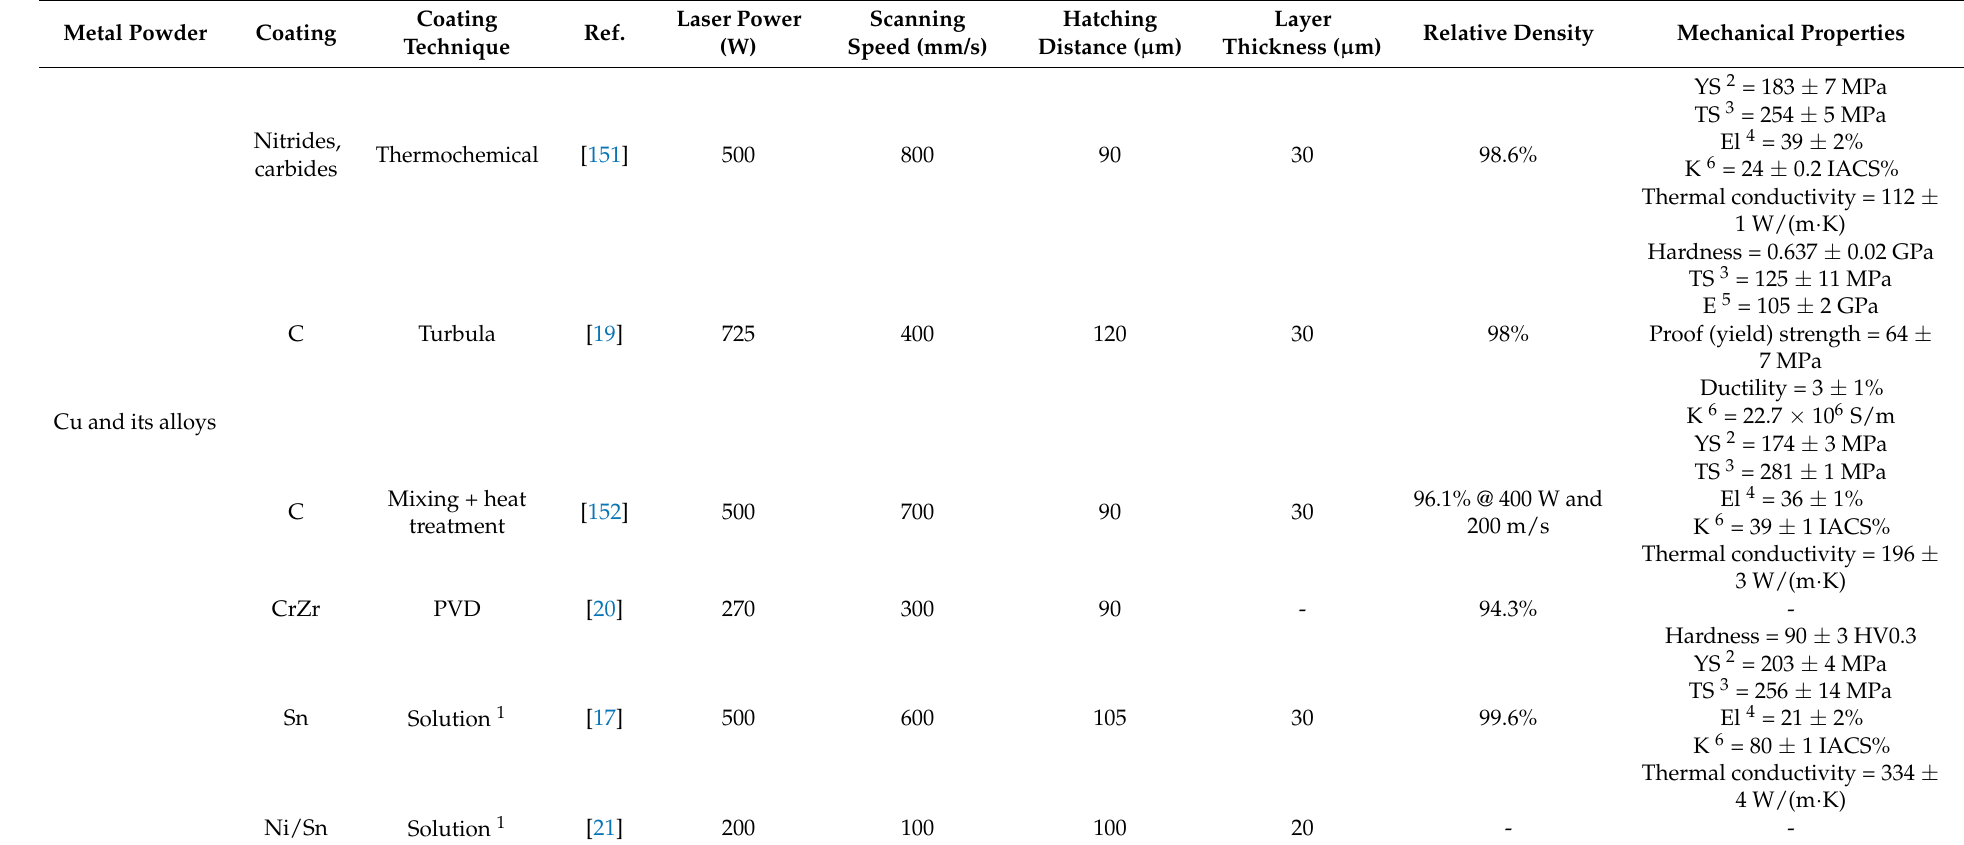
Table 5. A summary table reporting L-PBF process parameters, relative density and mechanical properties of printed parts using Cu-based alloys. Metal